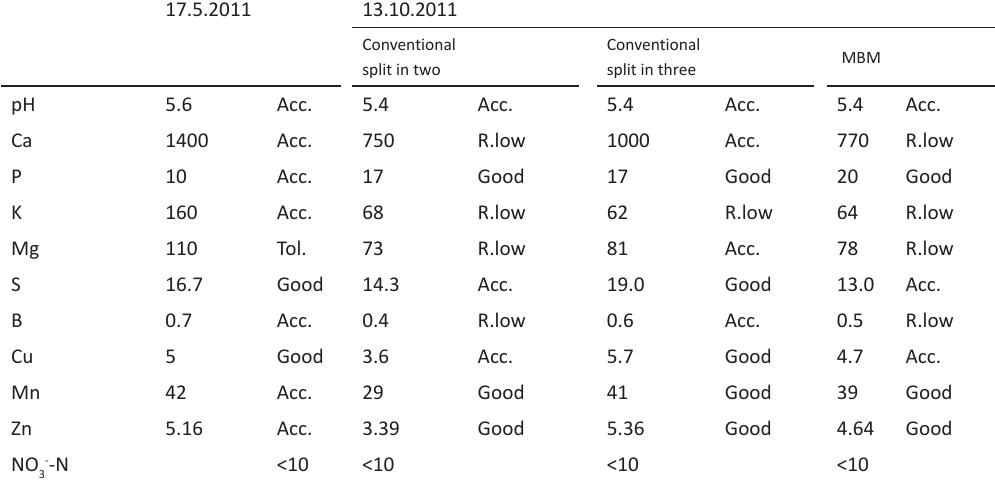
Table 7. Soil analysis results prior to sowing and post-harvest in 2011 for the carrot trial (mg l -1 , except pH and NO 3- -N kg ha -1